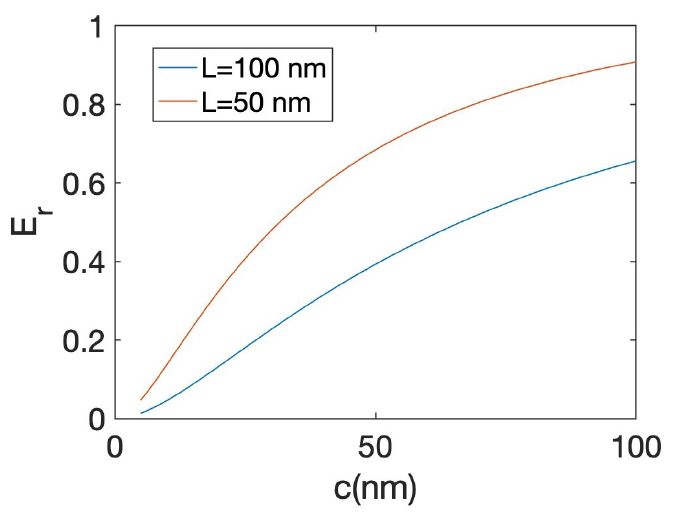
Figure 3. For two fixed separations between the plates, L = 50 nm and L = 100 nm, the ratio E r increases with increasing the value of the thickness c , leveling-off asymptotically to the value expected for half-spaces. The dimensions of the plate are a = b = 2000 nm.